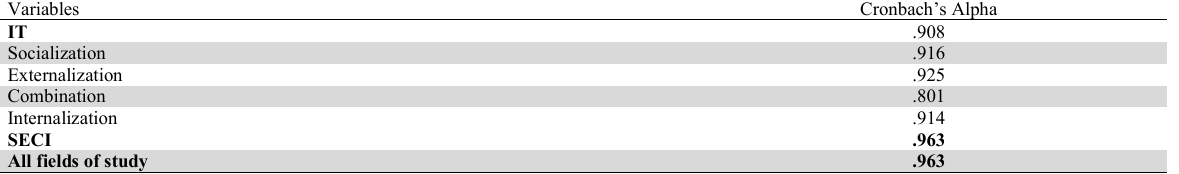
Internal consistency coefficient (Cronbach alpha) for the study instrument Variables